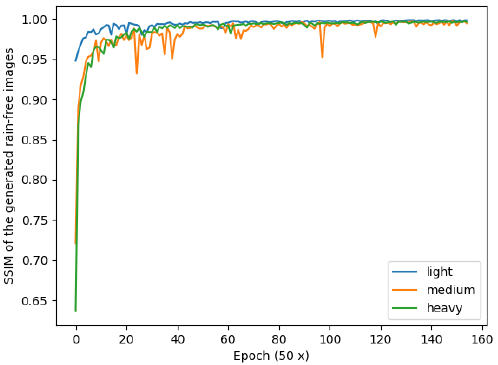
Figure 10. SSIM of the reconstructed rain-free images from light, medium, and heavy rainy images.